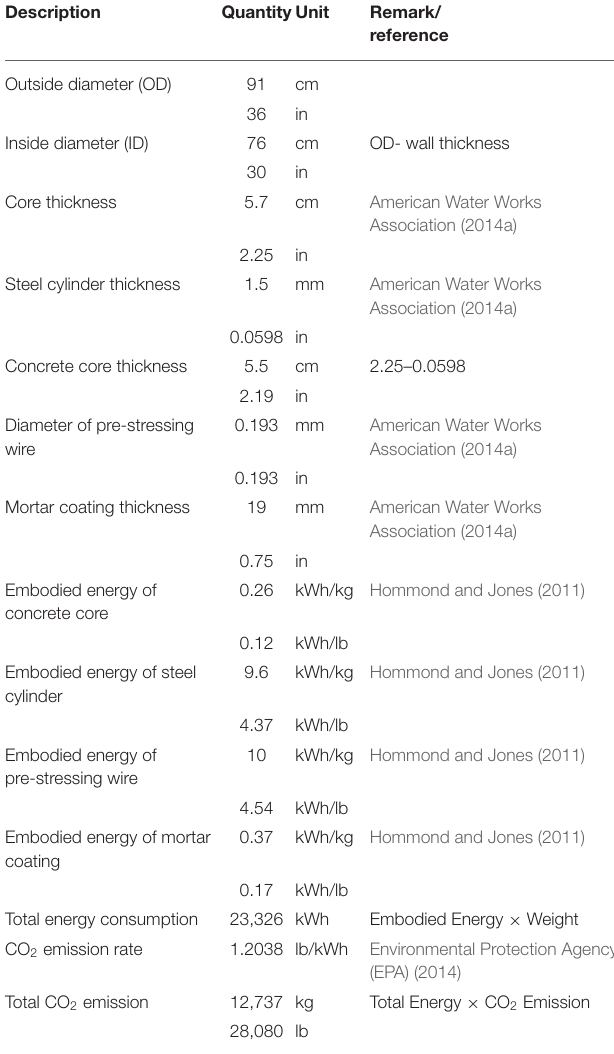
TABLE 1 | Carbon emission for PCCP